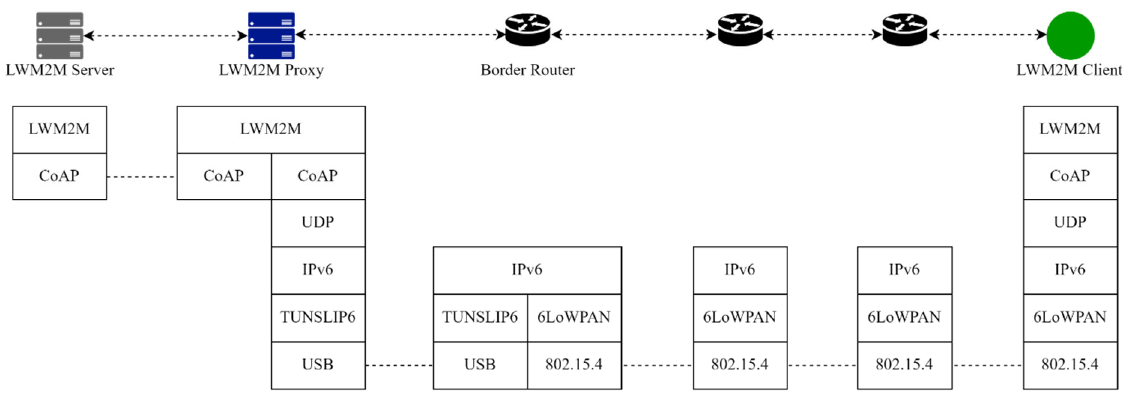
Figure 5. LWM2M architecture instantiated in a 6LoWPAN network.